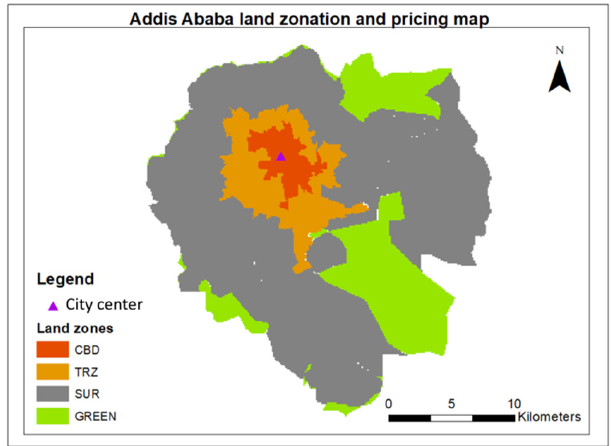
Figure 13. Land zonation map of Addis Ababa according to the benchmarking prices. CBD = central business district, TRZ = transitional zone, SUR = suburban zone, and Green = green area. Source: based on the shape files and benchmark land price data from Addis Ababa’s Integrated Land Infor- mation Center (ILIC).